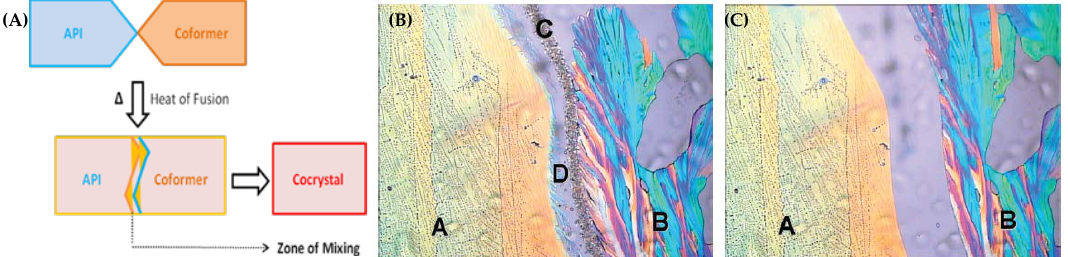
Figure 13. ( A ) Schematic representation of Hot-Stage Microscopy (HSM) functioning principle [210], formation of lamotrigine-caffeine (2:1) cocrystal using HSM technique. Contact area between lamotrigine and caffeine ( B ) At 190 °C [A—caffeine in solid-state; B—lamotrigine in solid state; D—Melting of eutectic and C—Formation of cocrystal phase] and ( C ) At 200 °C [A—caffeine in solid-state; B—lamotrigine in solid state; C and D observed in Figure 13B disappears due to complete melting of the cocrystal phase] [Reprinted from [211] with permission. Copyright 2012 American Chemical Society].